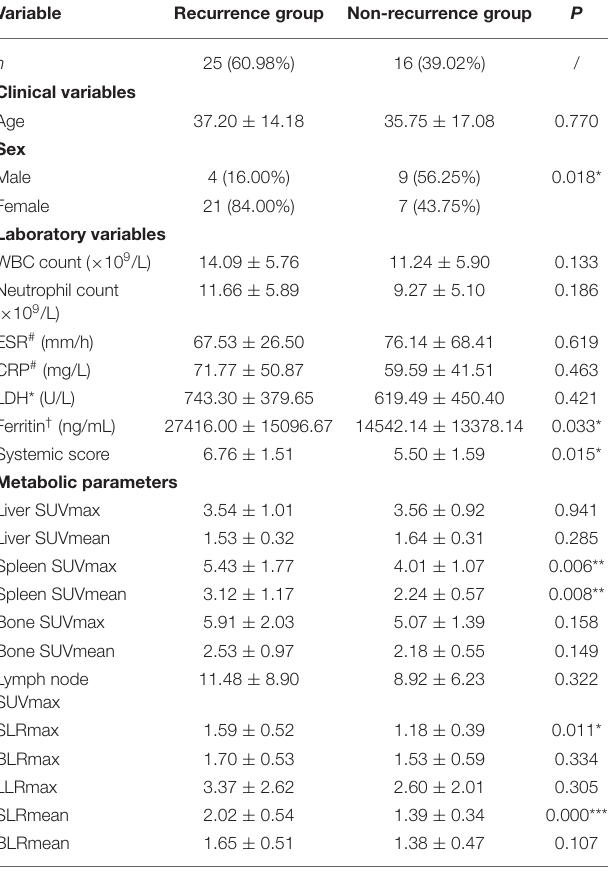
TABLE 3 | Comparison of laboratory variables and metabolic parameters between AOSD recurrence group and non-recurrence group.